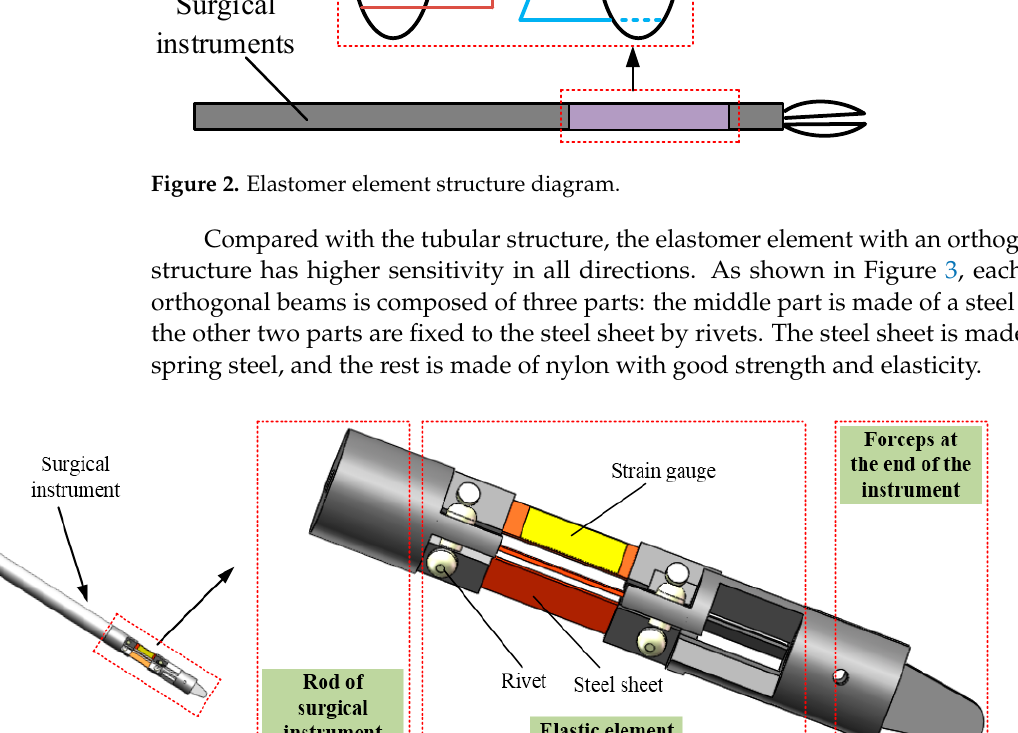
Figure 2. Elastomer element structure diagram.